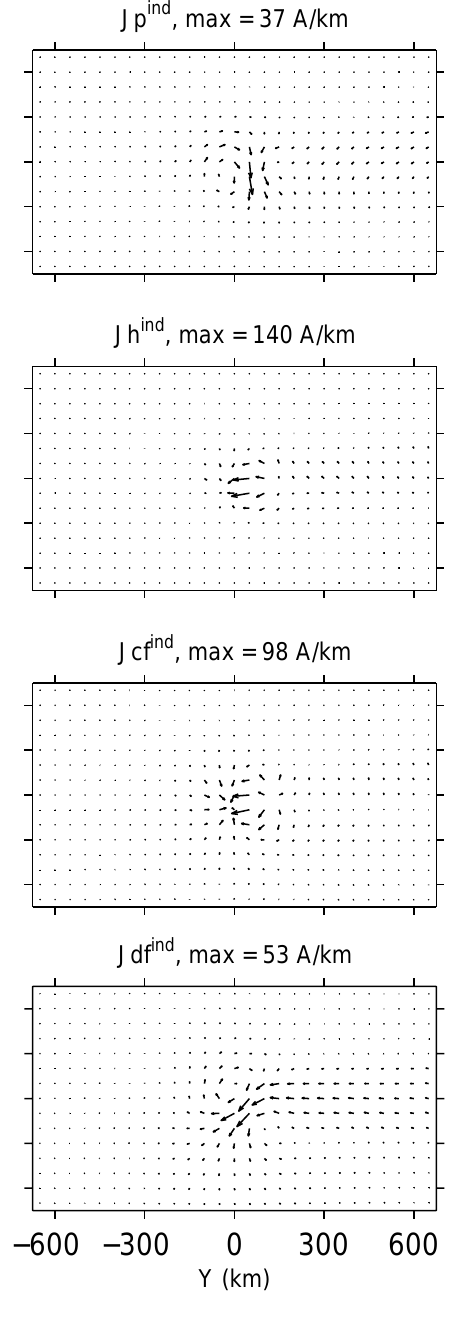
Fig. 9. Same as Fig. 6, but for the WTS